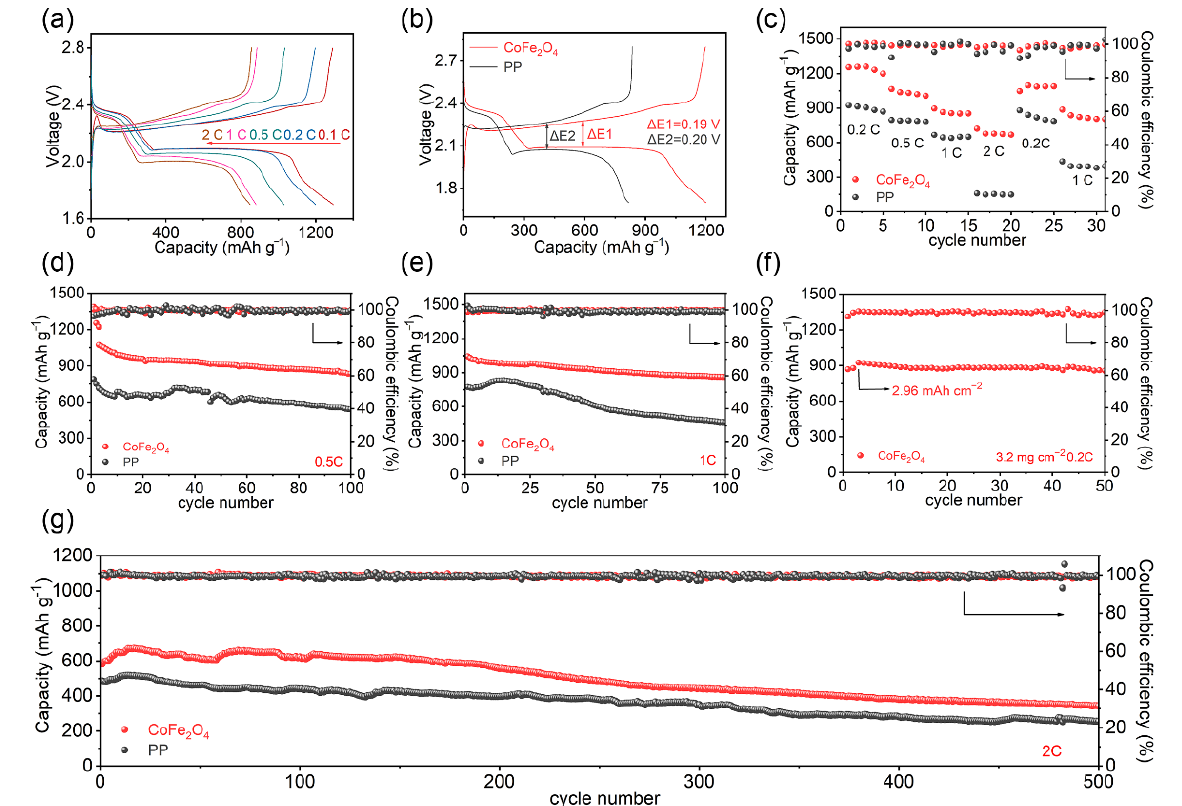
Figure 5. ( a ) Galvanostatic discharge–charge profiles of lithium–sulfur batteries with a CoFe 2 O 4 - modified separator at different rates; ( b ) comparison of discharge–charge curves at 0.2 C; ( c ) rate performance; ( d , e , g ) cyclic stability tests at 0.5, 1, and 2 C; ( f ) high load performance of the CoFe 2 O 4 - based battery. For Figure ( g ): 2C in the lower right corner means that both the CoFe 2 O 4 -modified separator and the PP separator assembled battery are tested for cycle stability at 2C. The two beating data points in the upper right corner are normal phenomena that occur during testing. The lithium- sulfur battery assembled without a modified separator has undergone hundreds of charge and discharge processes inside the battery after a long cycle. The consequences of the shuttle effect in this process will lead to unstable charging and discharging, so the data points corresponding to the Coulombic effect